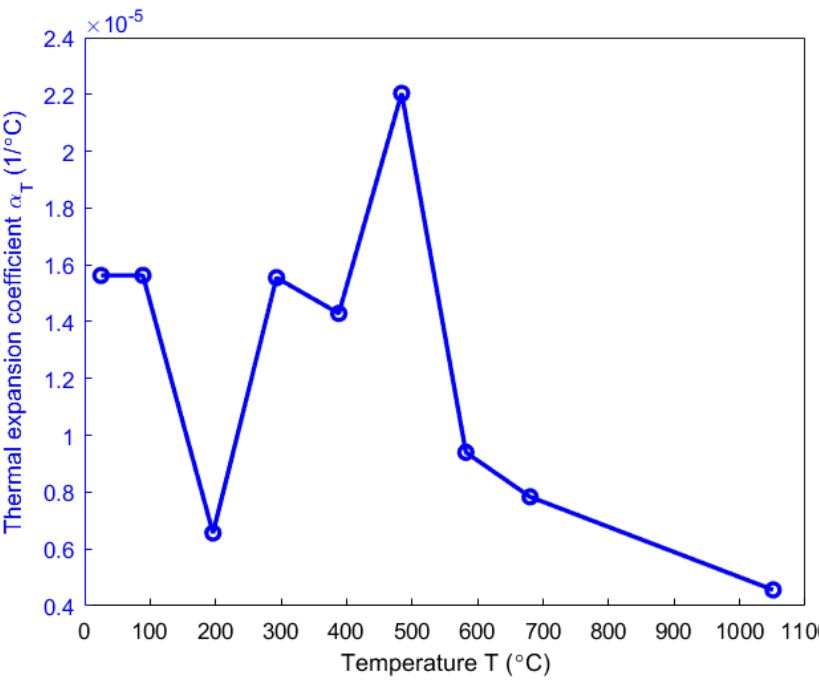
Figure 14. Evolution of thermal expansion coefficient with respect to temperature.